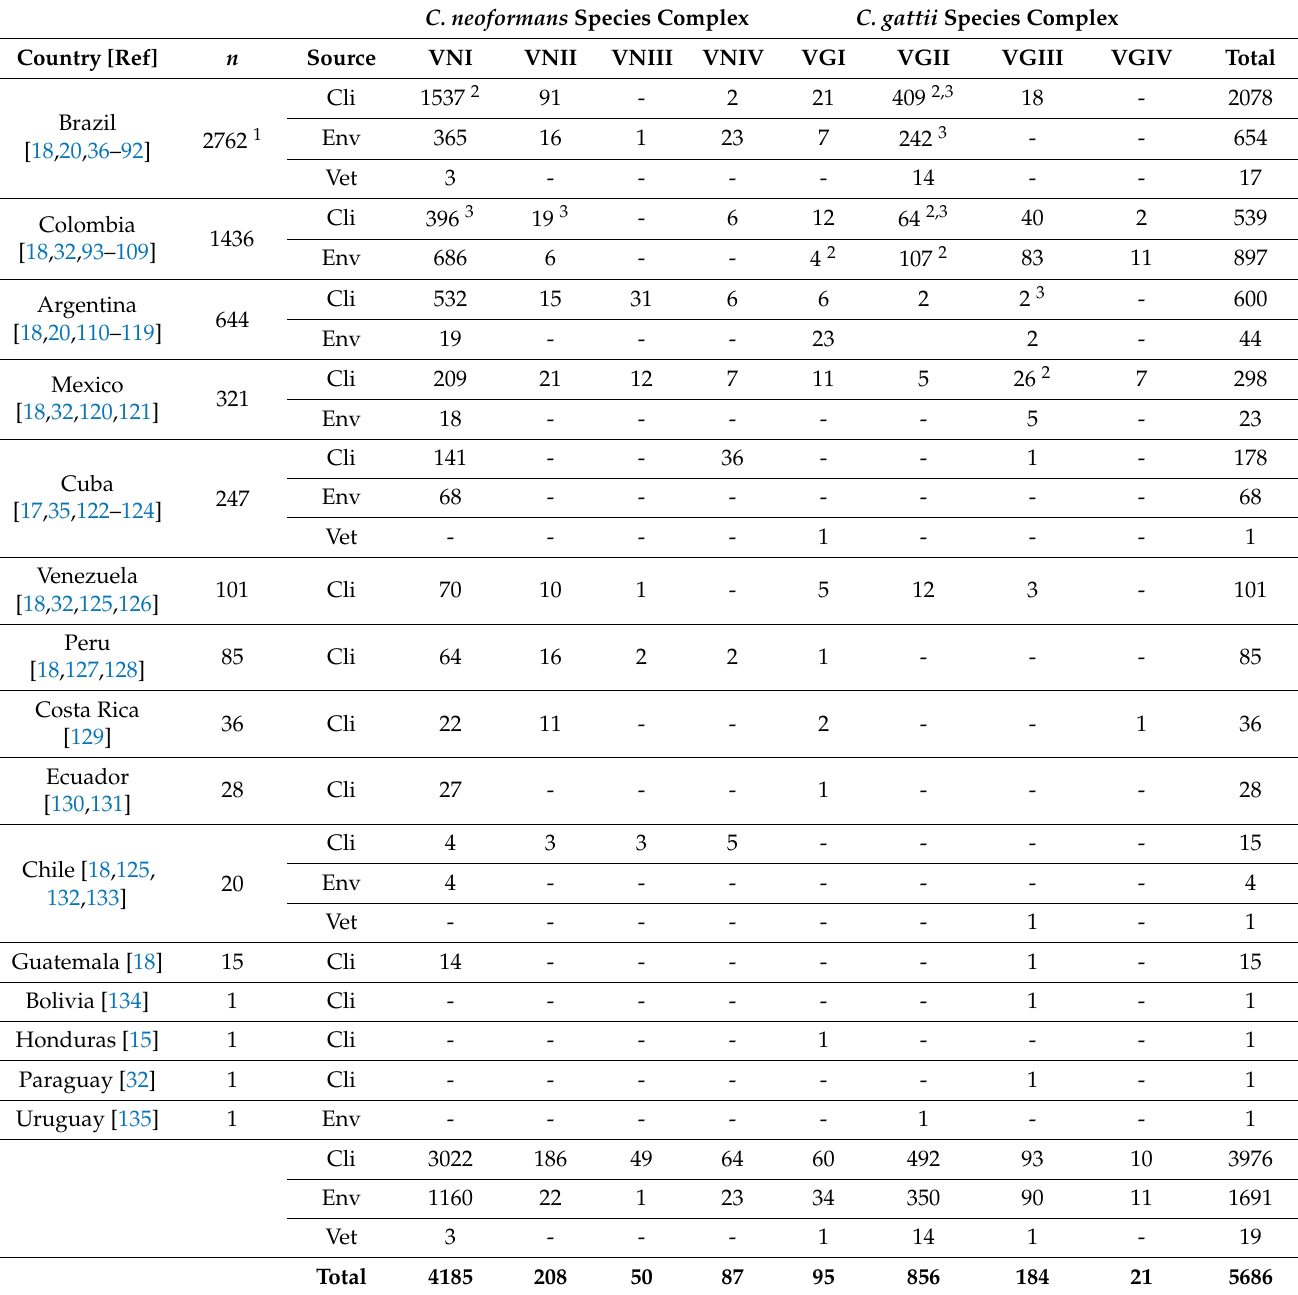
Table 1. Distribution of the major molecular types of Cryptococcus neoformans and Cryptococcus gattii species complexes isolates reported from Latin American